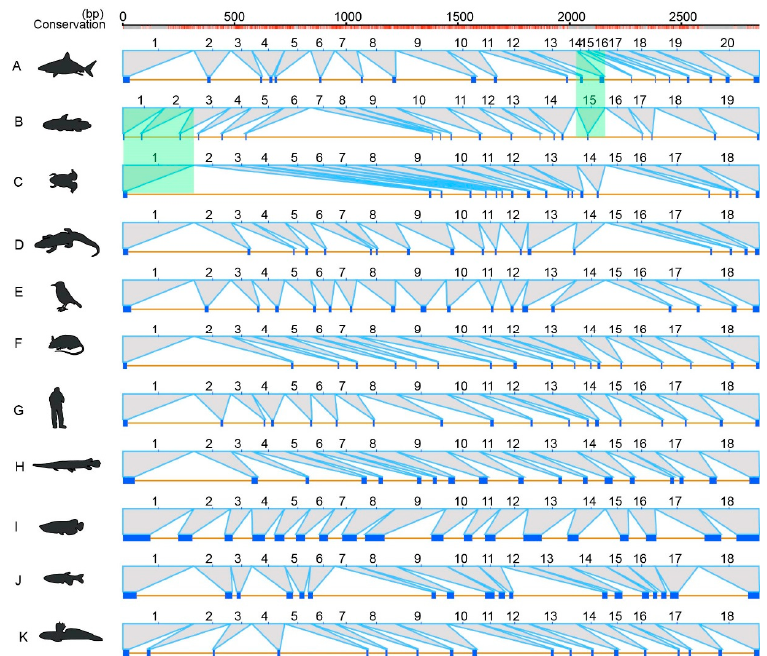
Figure 6. Sequence alignments of the ace2 gene structures in 11 representative vertebrates. The green color shaded regions indicate the species-special variations. Find corresponding species names ( A – K ) in the legend of Figure